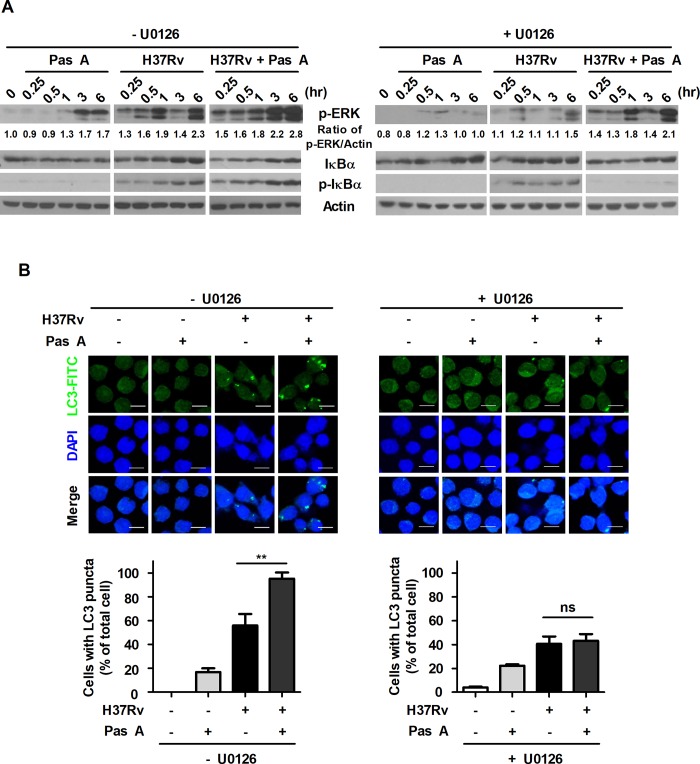
Pasakbumin A induces autophagy by activating ERK1/2-mediated signaling.Raw264.7 cells were pre-treated with U0126 (10 μM) for 1 h and then stimulated with pasakbumin A (Pas A, 10 μM) during H37Rv infection (MOI of 1 or 5). (A) The changes in the phosphorylated and total protein levels of ERK1/2 and IκBα were assessed using western blot analysis. Cropped membrane from different gels was used in western blot assay. The band intensity was quantified, and the ratio of p-ERK band intensity was shown in bottom of the blot. (B) Immunofluorescence staining of LC3 in Mtb-infected cells treated as described above. The number of LC3-positive puncta was counted under a microscope, and the percentage of cells containing LC3-positive puncta relative to the total cell number was calculated. Bar scale, 20 μM. Statistical significance is indicated as *, p<0.05 and ns, not significant (p>0.05).